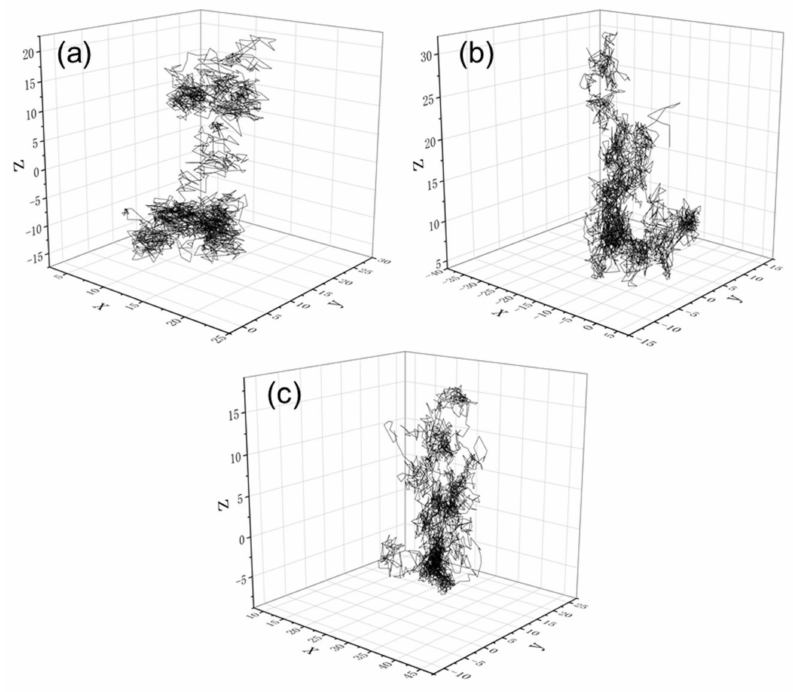
Figure 6. Trajectories of the three gases in PDMS membranes at 298 K: ( a ) N 2 ( b ) C 3 H 8 and ( c ) C 3 H